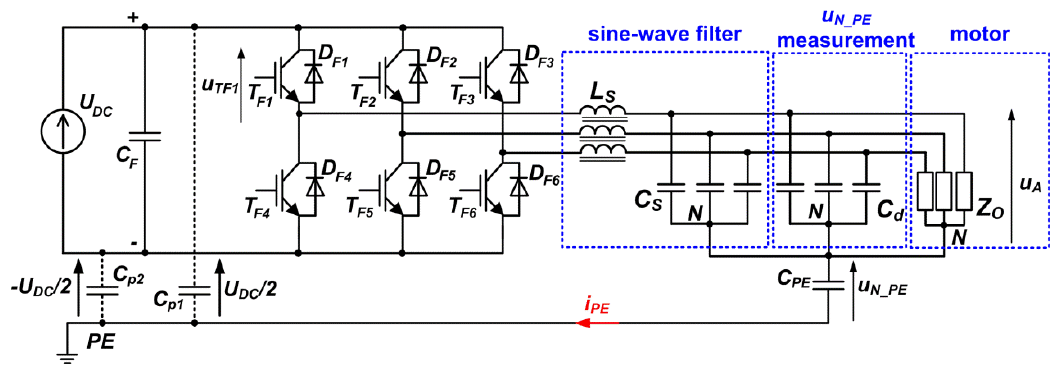
Figure 26. Electric drive fed by a conventional hard-switched two-level bridge voltage inverter in a configuration with a sine-wave filter.